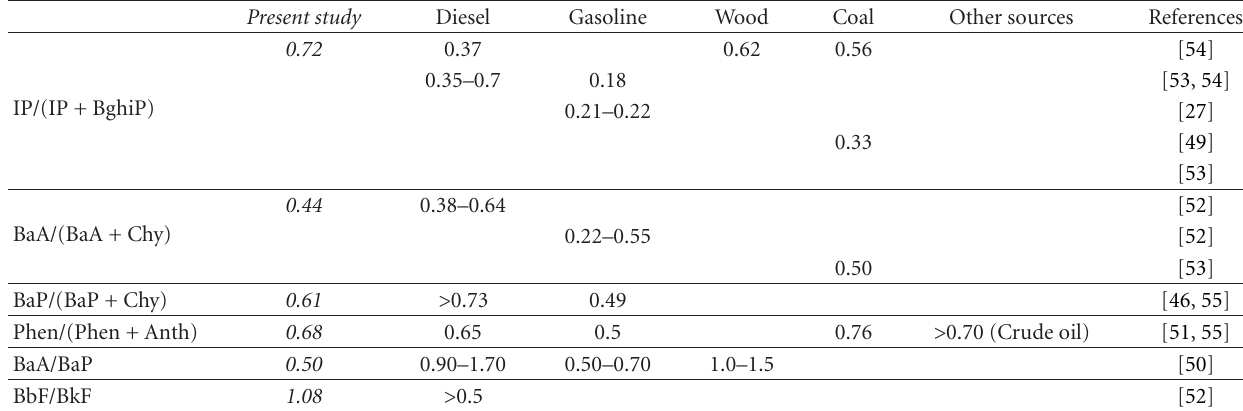
Table 3: Diagnostic